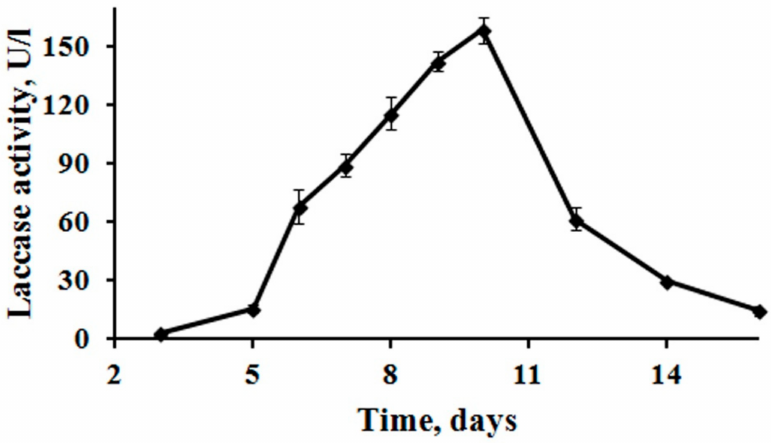
Figure 1. Production of laccase by M. elasson during growth on medium